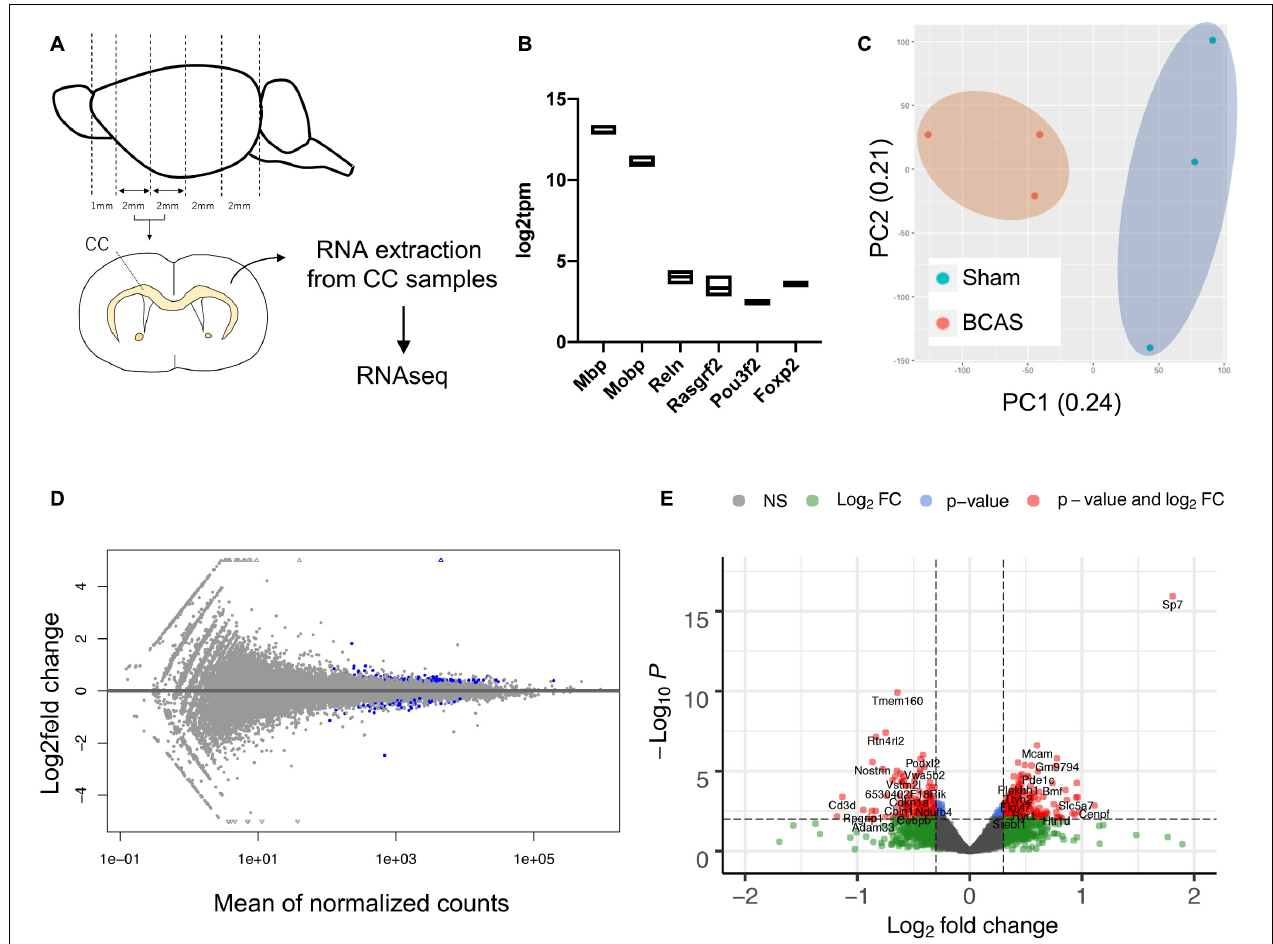
FIGURE 2 | Gene expression changes in mouse corpus callosum after 4-week cerebral hypoperfusion. (A) Diagram for corpus callosum preparation. Four weeks after sham or BCAS operation, mice were sacrificed, and the corpus callosum samples were prepared. From each group, three mice were used for the RNAseq studies. CC: corpus callosum. (B) Gene expression levels of oligodendrocyte markers (Mbp and Mobp) were much higher than that of cortical neuron markers (Reln for layer I, Rasgrf2 for layer II/III, Pou3f2 for layers II-V, and Foxp2 for layer IV). (C) The principal component analysis (PCA) plot. (D) The MA plot. Blue dots represent the genes with adjusted p -value < 0.1 against the sham group. (E) The volcano plot. The red dots represent the genes that showed | log2 fold change| > 0.3 with adjusted p -value < 0.1 against the sham group. Please see Supplementary Table 2 for the list of differentially expressed genes between sham- and BCAS-operated